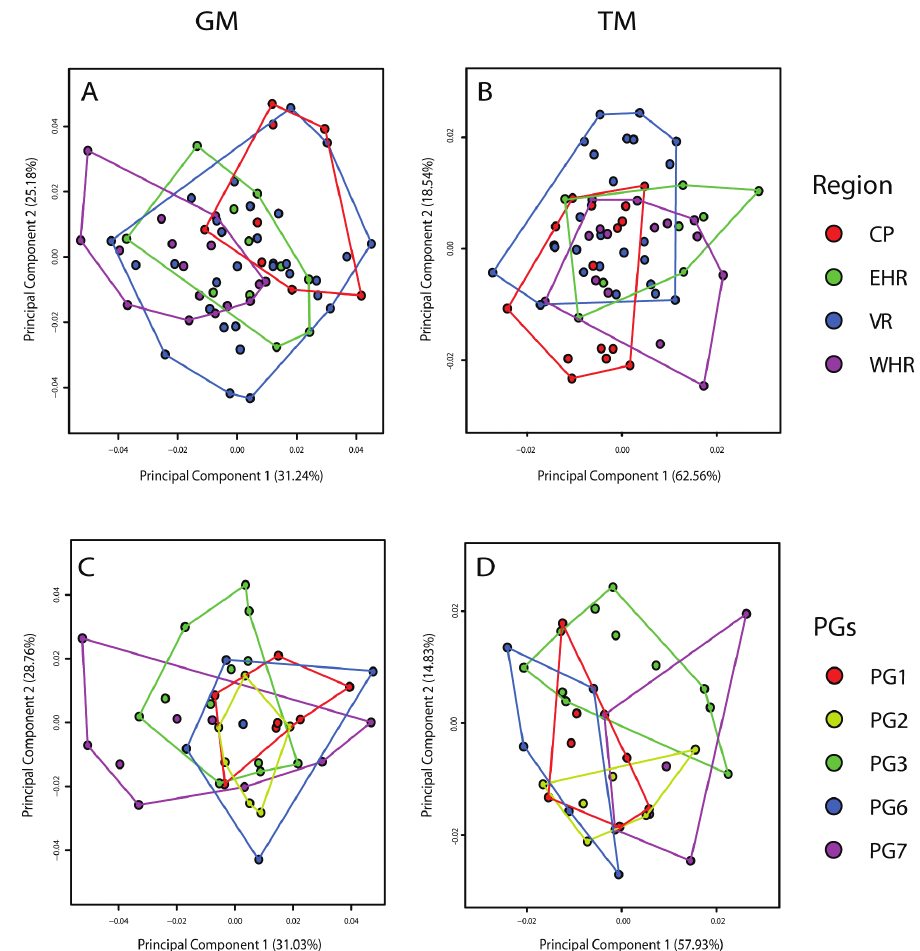
Figure 6. PCA results from both geometric morphometric (left) and traditional morphometric (right) analyses. A, B Total morphometric dataset (n=65) grouped by physiographic province. C, D Morpho- metric dataset with complimentary molecular data (n=39) grouped by MOTUs from the mPTP